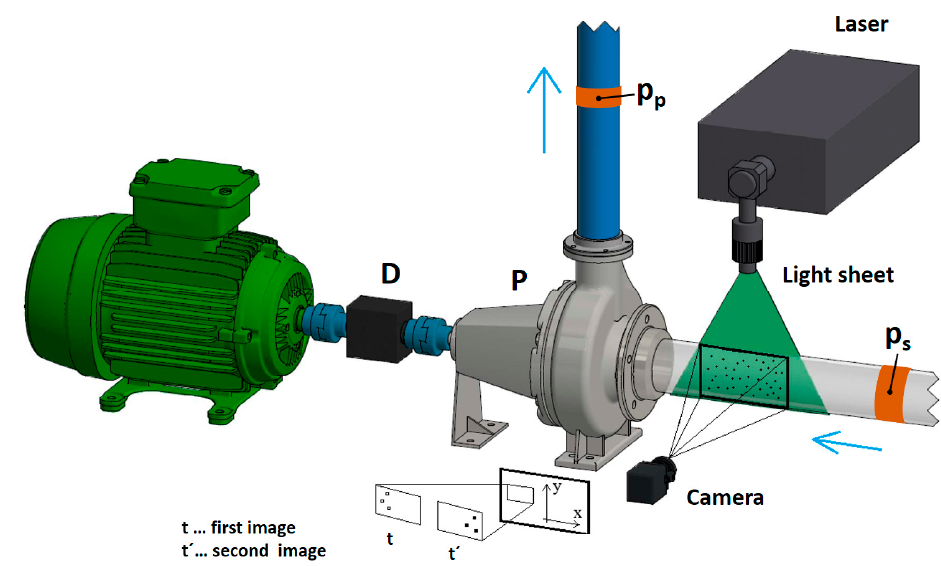
Figure 1. Diagram of setting for pump testing.